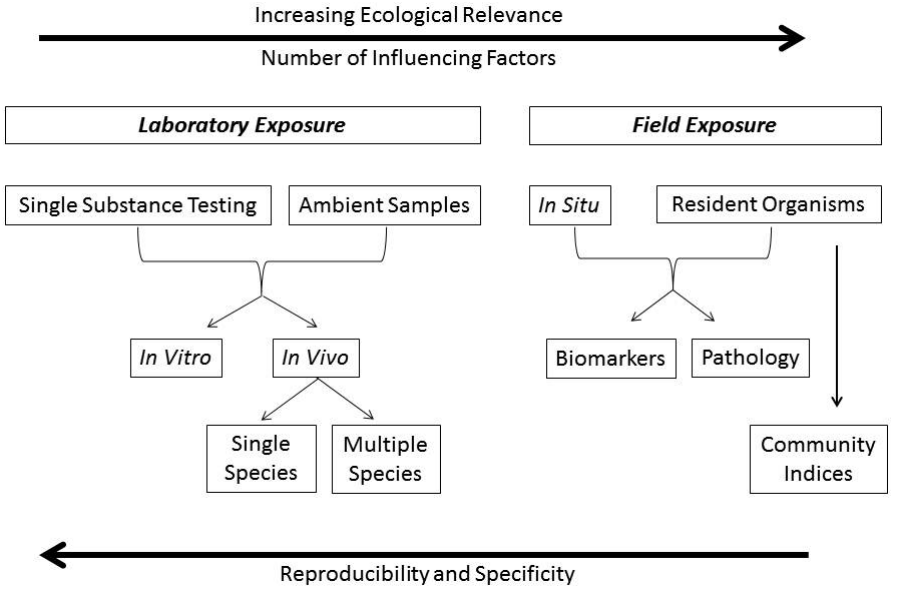
Figure 4. Different biological approaches exist for measuring toxicity of chemicals and their effects in the aquatic environment. With increasing ecological relevance the reproducibility, specificity and thus suitability for standardization of methods